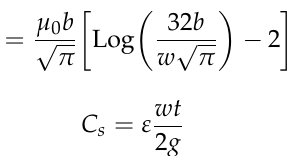
Figure 1. Three-dimensional interpretation of the proposed rectangular microstrip patch antenna. Two superstrate layers of substrates are used. The patch consists of a rectangular cut/cropped slot. Three SRRs with the tooth are located at the top of the upper substrate.